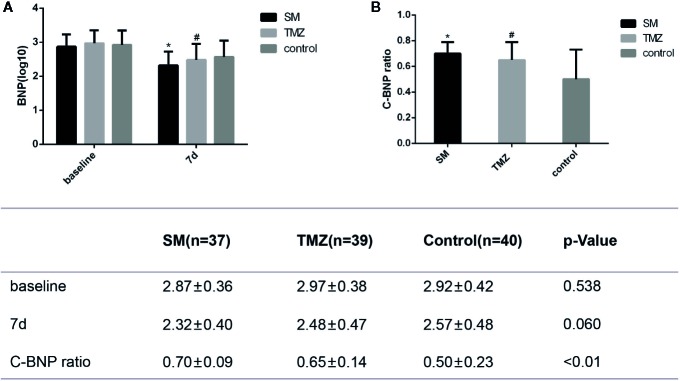
The effects of the SM, TMZ, and control treatments on C-BNP in HF patients. (A) Levels of BNP at baseline and after 7 days of treatment in the SM, TMZ, and control groups; *P <0.01 vs. the baseline of SM; #P < 0.01 vs. the baseline of TMZ; the control group (7 days), P < 0.01 vs. the baseline of control; *P < 0.05 and #P > 0.05 compared with the control group (7 days); (B) C-BNP ratio in the SM, TMZ, and control groups after 7 days; *P < 0.01 or #P < 0.01 vs. the control group (7 days). C-BNP ratio=log10(10baseline-107d)/baseline. 7d, 7days.